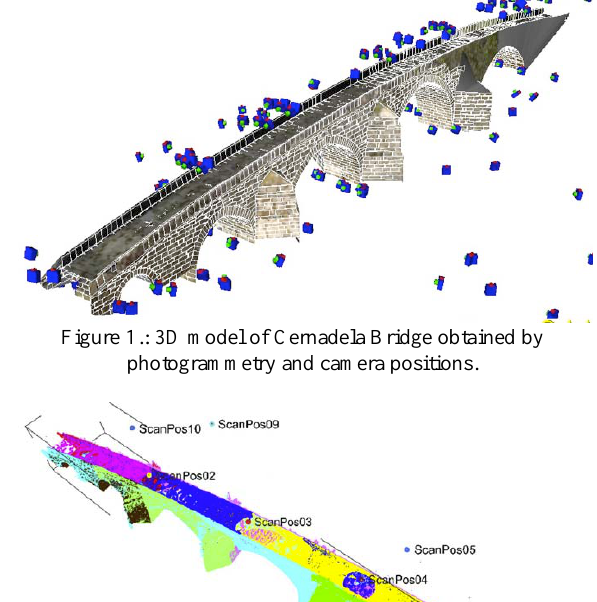
Figure 2.: Global point cloud of Cernadela Bridge acquired from 10 different scanner